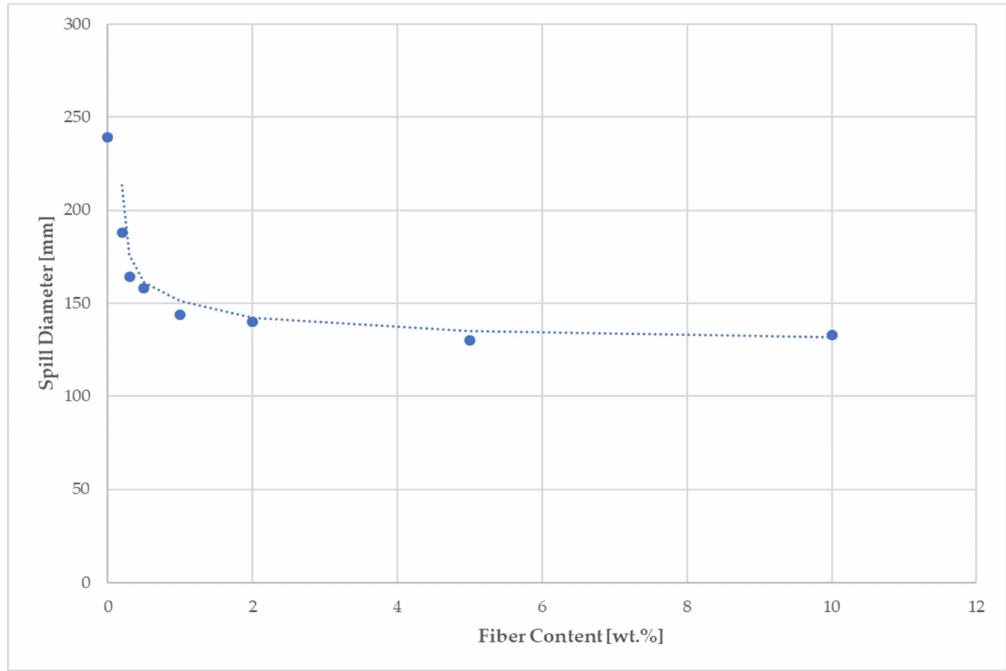
Figure 6. Effect of fiber content (sample C) on the consistency of the fiber-cement fresh